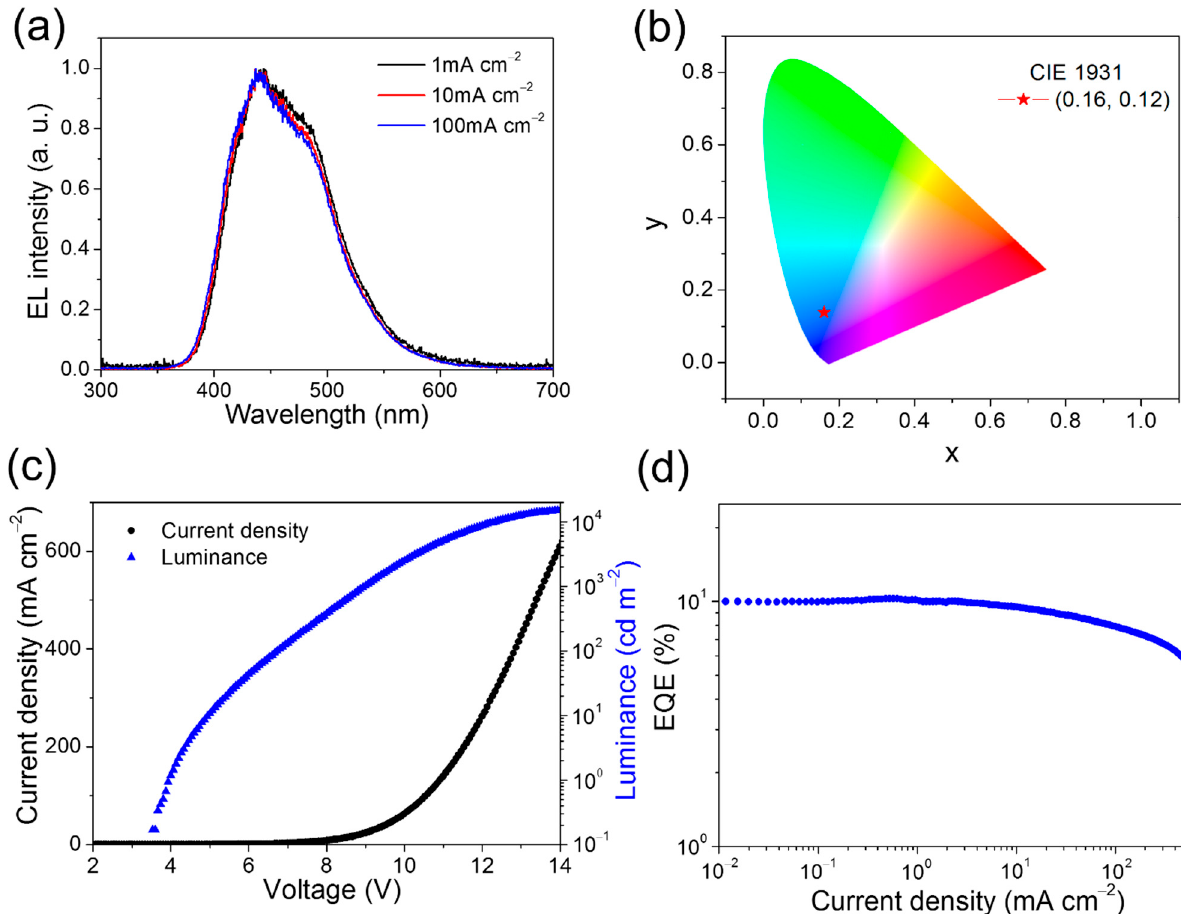
Figure 4. EL characteristics of the 8 wt % HAP-3FDPA:mCP exciplex-based OLED. ( a ) The EL spectra at various current densities. ( b ) The CIE coordinates of (0.16, 0.12) for EL spectra. ( c ) The current efficiency-voltage-luminance ( J - V - L ) characteristics. ( d ) EQE as a function of current density. Table 2. The OLED performance based on an 8 wt % HAP-3FDPA:mCP exciplex system.